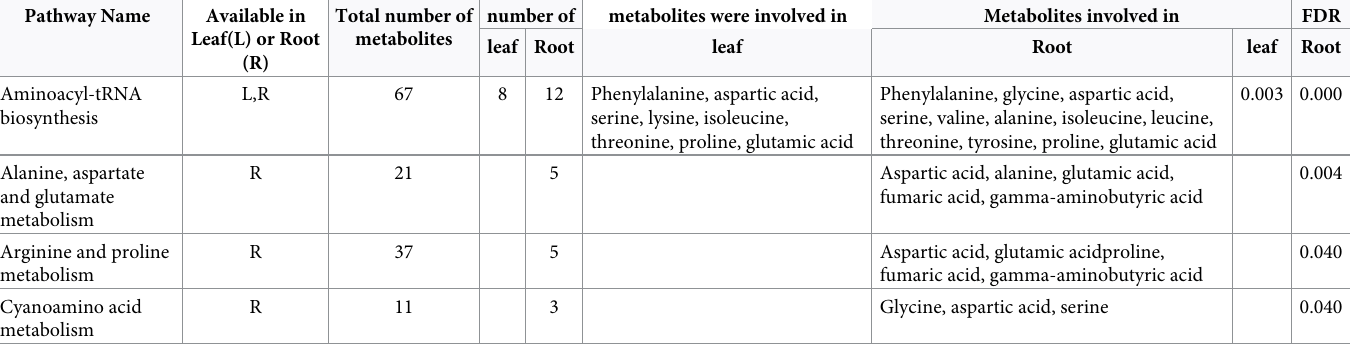
Table 6. Pathway names, total metabolites involved in those pathways, metabolites significantly accumulated in present study (hits), and false discovery rate (FDR) in wheat flag leaves and roots of AGS2038 identified by Pathway Analysis of MetaboAnalyst 3 using Oryza sativa japonica as the pathway